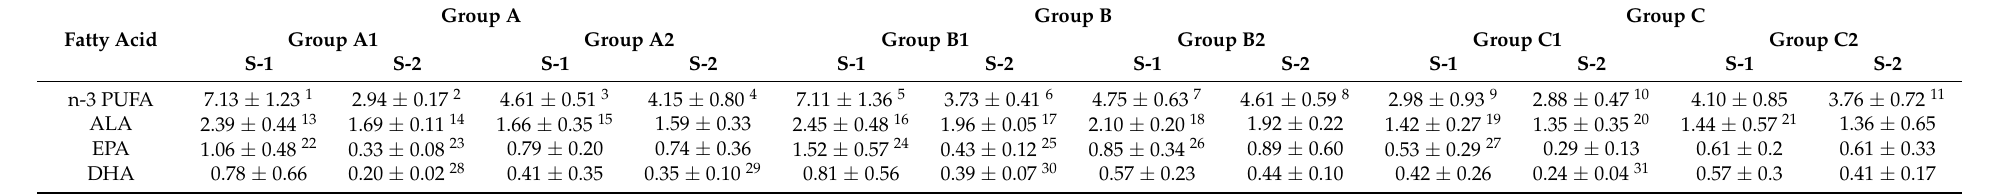
Table 3. Values (mean ± SD) of n-3 PUFA, in muscle of lambs (g/100 g of fatty acids, in dry